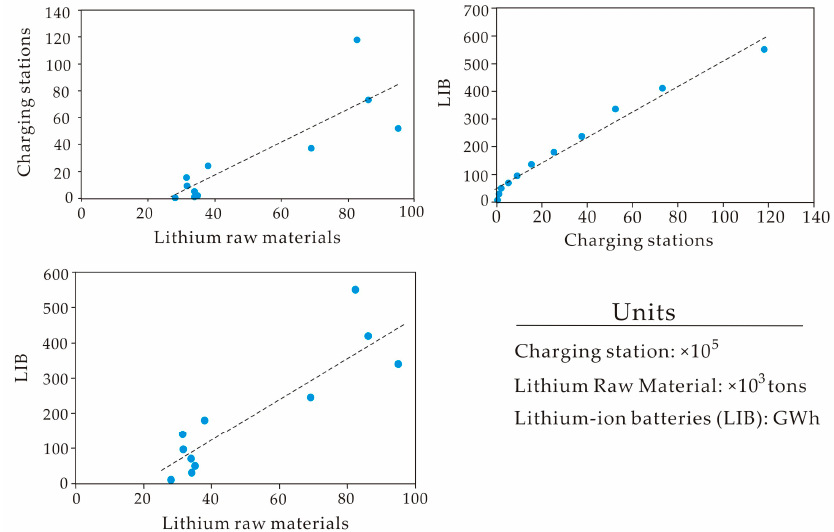
Figure 8. Scatter diagram showing the correlation between global lithium-ion batteries, global lithium raw materials, and global charging stations.